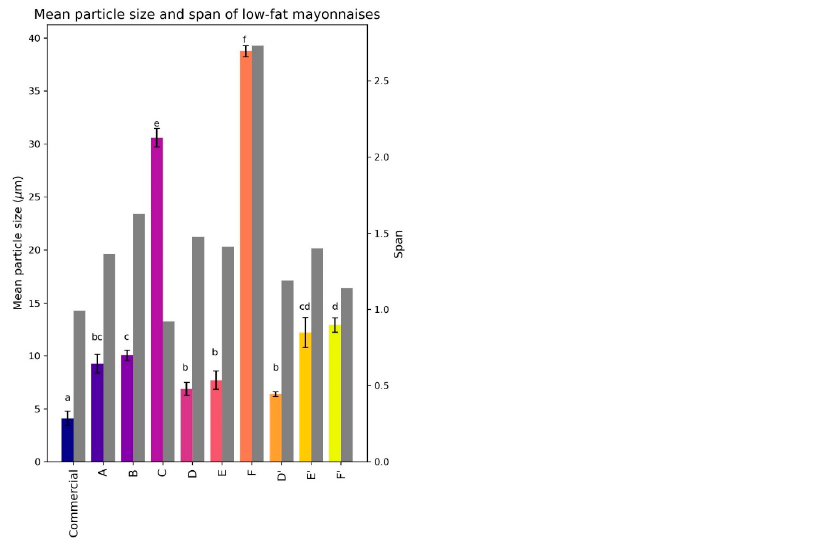
Figure 2. Mean particle size (color bars) and span (gray bars) of the low-fat mayonnaises. A, B, C = sodium alginate low fat mayonnaise with 30, 22.5 and 15% oil. D, E, F = low fat mayonnaises with 30, 22.5 and 15% oil and soy protein isolate. D’, E’, F’ = low fat mayonnaises with 30, 22.5 and 15% oil and spirulina protein concentrate. The different superscript letter indicates a significant difference ( p < 0.05).